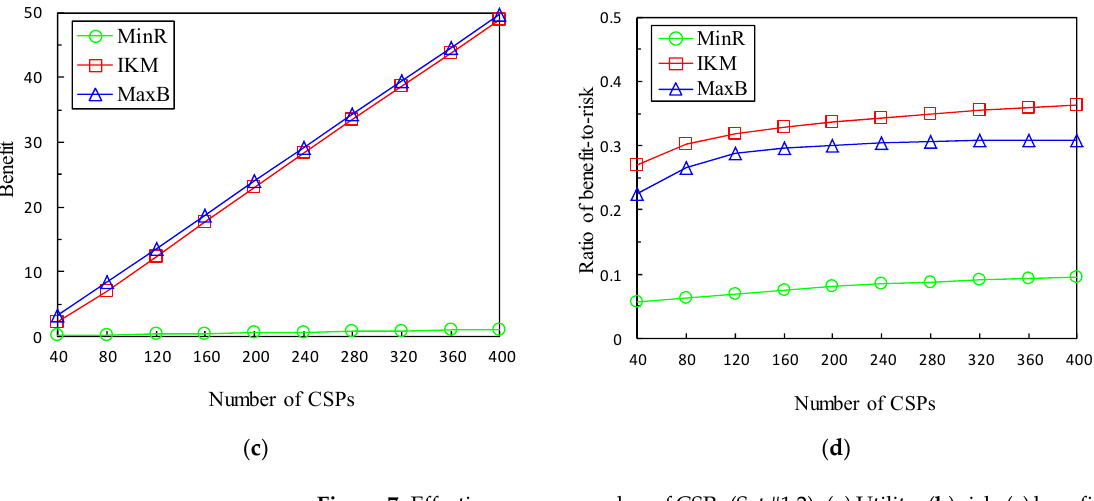
Figure 7. Effectiveness vs. number of CSPs (Set #1.2). ( a ) Utility; ( b ) risk; ( c ) benefit; ( d ) benefit − to − risk ratio.